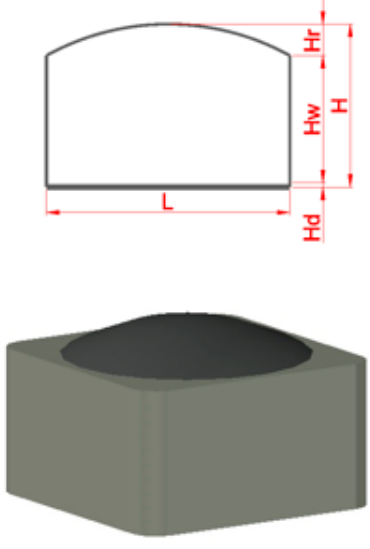
Figure 15. Side and isometric views of tank with dome roof.